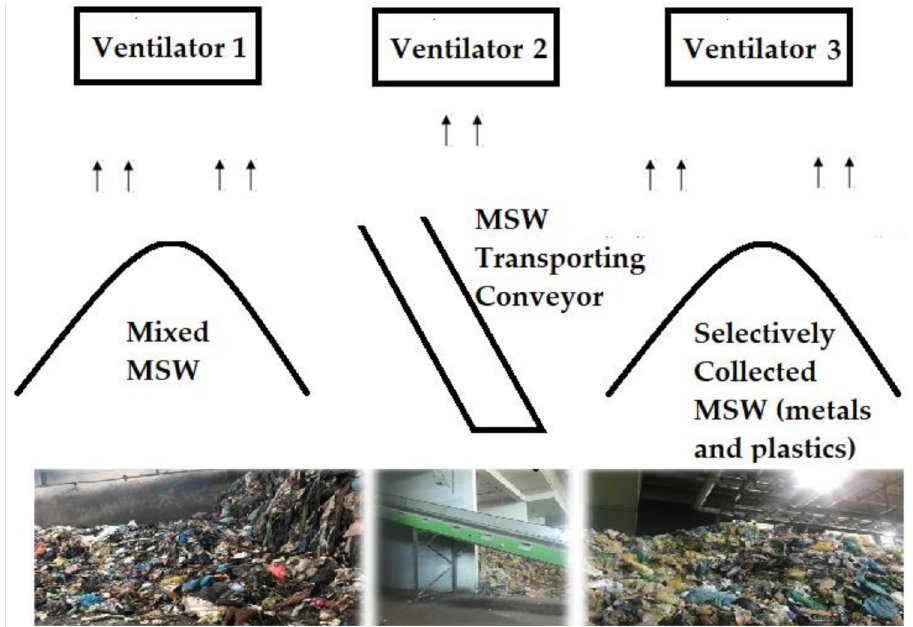
Figure 1. Scheme of the hall for waste unloading and storage at the MWBP.